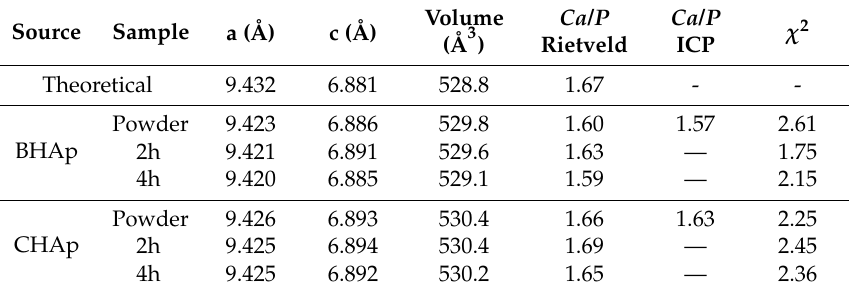
Table 2. Structural parameters obtained from XRD patterns analyzed by Rietveld refinement. Source